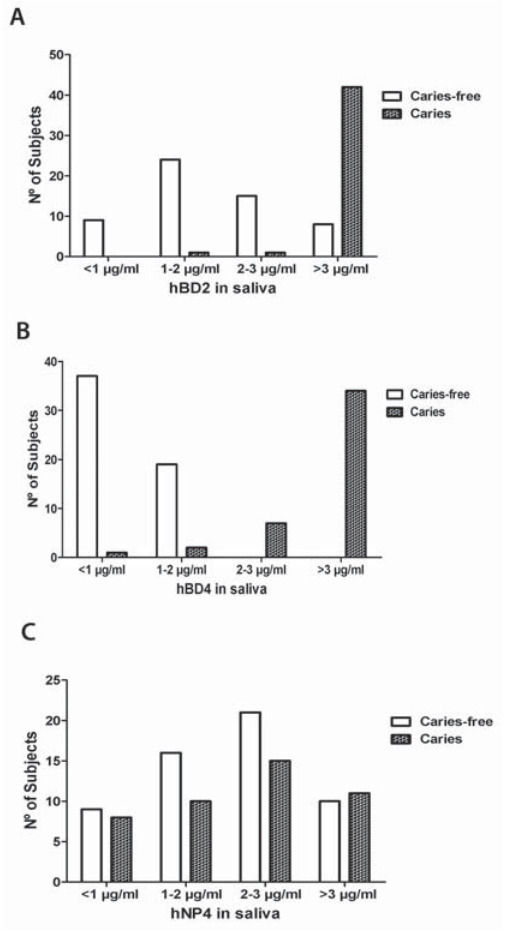
FIGURE 4. Defensins values and caries in the population. The number of subjects with no caries (open bars) compared to those with caries ( fi lled bars) with hBD2 (A), hBD4 (B) and hNP4 (C) concentrations ( μ g/ml saliva) in the ranges indicat- ed. Note that an increasing proportion of subjects had caries as the defensins (hBD2 and hBD4) concentration increased. hNP4 analysis showed no signi fi cant differences among the population, with the same levels of hNP4 in caries and caries free